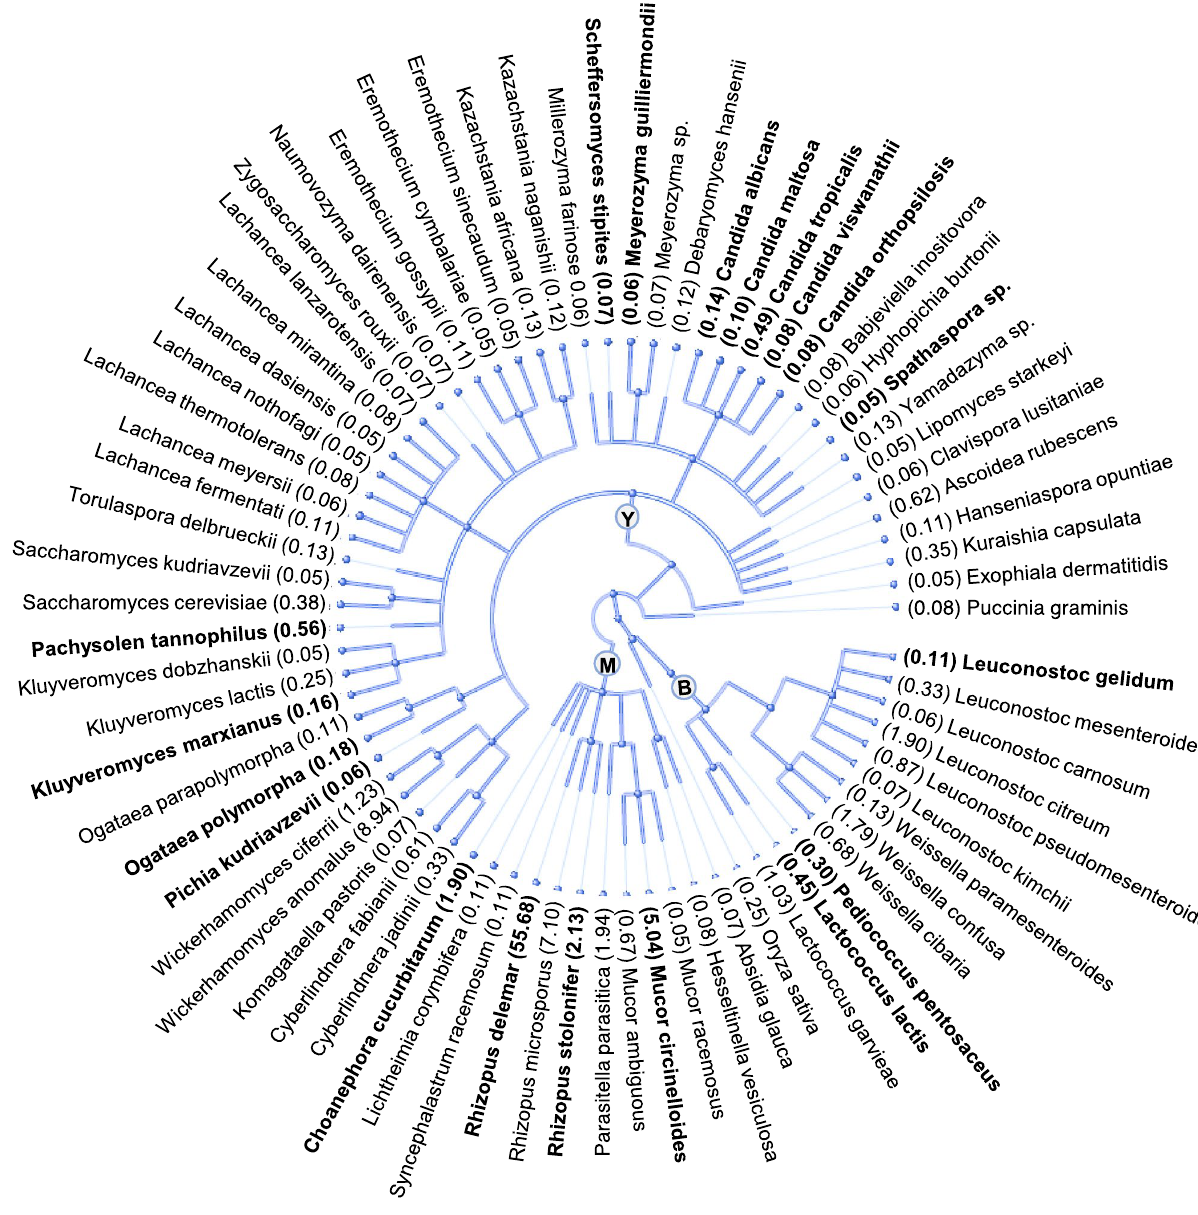
Figure 3. Phylogenetic tree of species as recorded in the emao. A total of 74 microbial species and 1 rice species were identified based on a ribosomal protein sequence homology search against the NCBI-nr database. The values within parentheses indicate the relative abundance in percent. Species names in bold (total 19) indicate the lignocellulose/pentose metabolizer as listed in Supplementary Data Table S3). B bacteria, M molds, Y